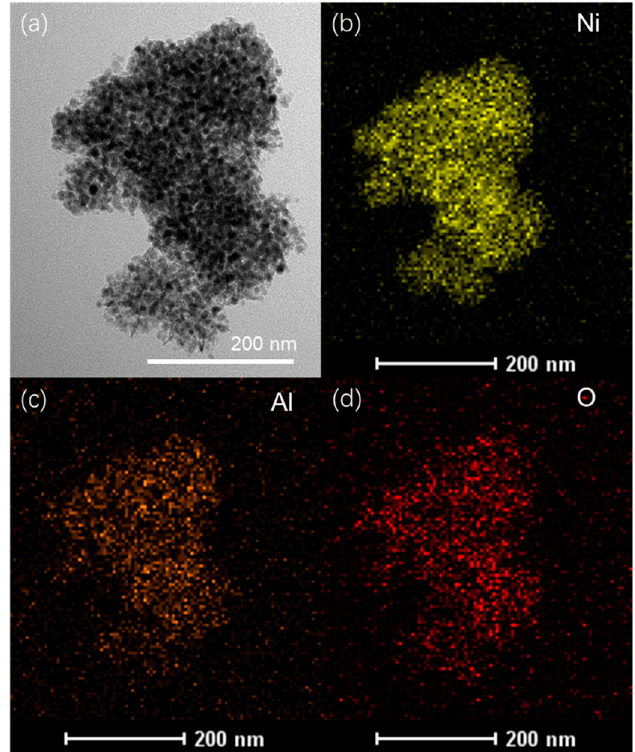
Figure 3. TEM image of reduced AMO-Ni 3 Al-CO 3 LDH solid ( a ) and corresponding EDX elemental mapping of AMO-Ni 3 Al-CO 3 LDH derived catalyst for Ni ( b ), Al ( c ), and O ( d ). TheCO 2 conversionandCH 4 selectivityovertheAMO-Ni 3 Al 1 -CO 3 -LDOandAMO-Ni 3 Al 1 -NO 3